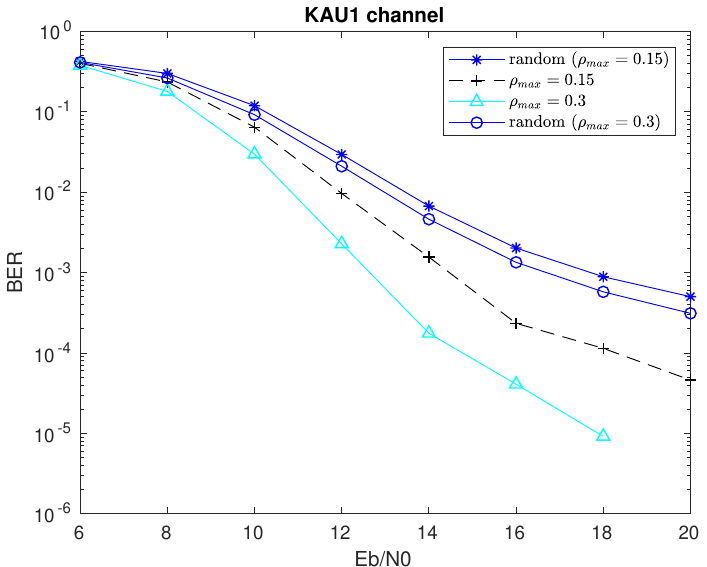
Figure 15. Modem operating at KAU1 channel, and for distinct maximum overhead